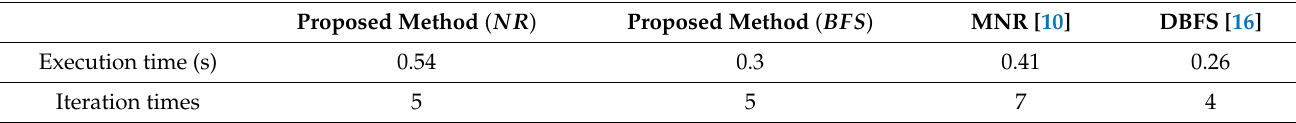
Table 7. Comparison of convergence characteristics.